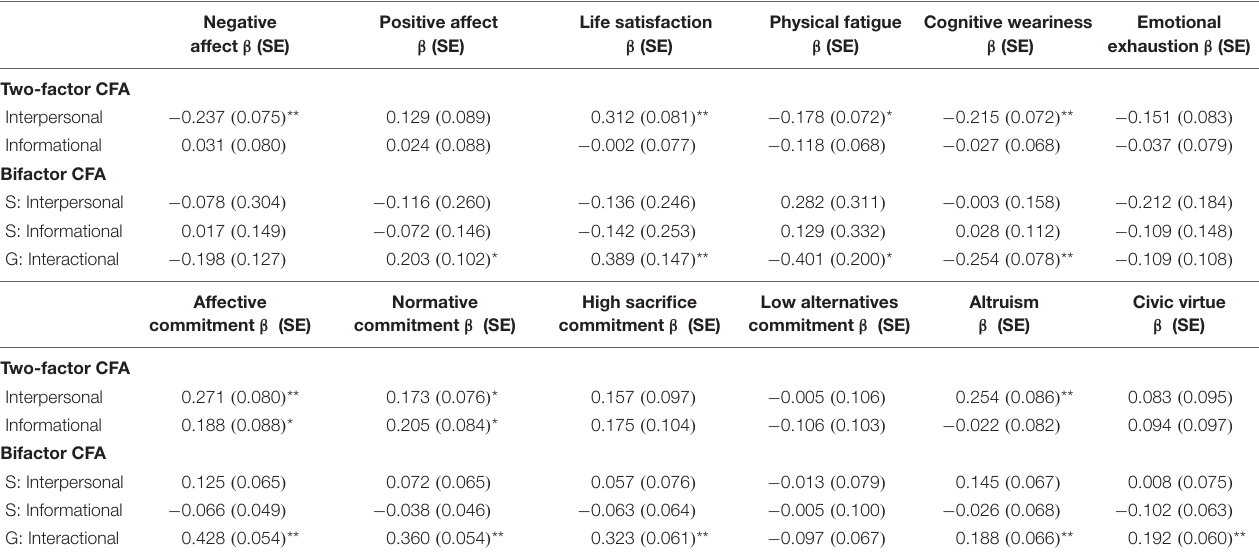
TABLE 3 | Effects of organizational justice on outcomes (Study